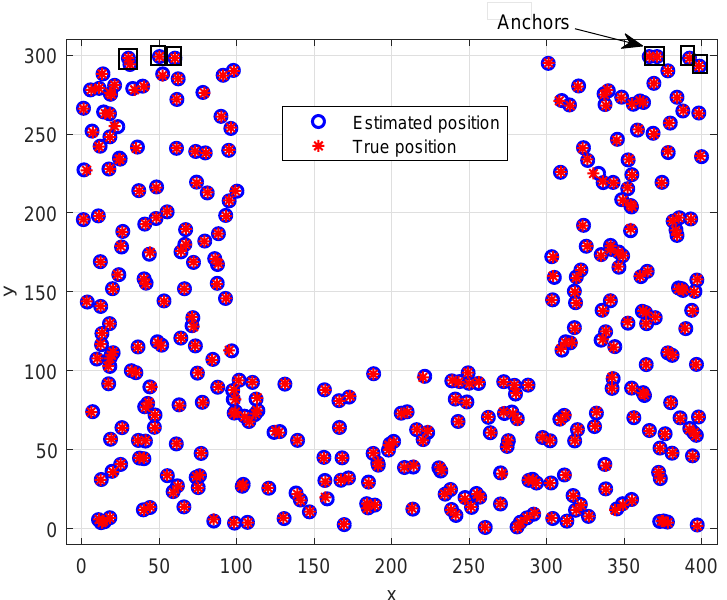
Figure 4. The true and estimated sensor positions at R = 40 and σ 2 = 0 dB, first configuration, MLE method.